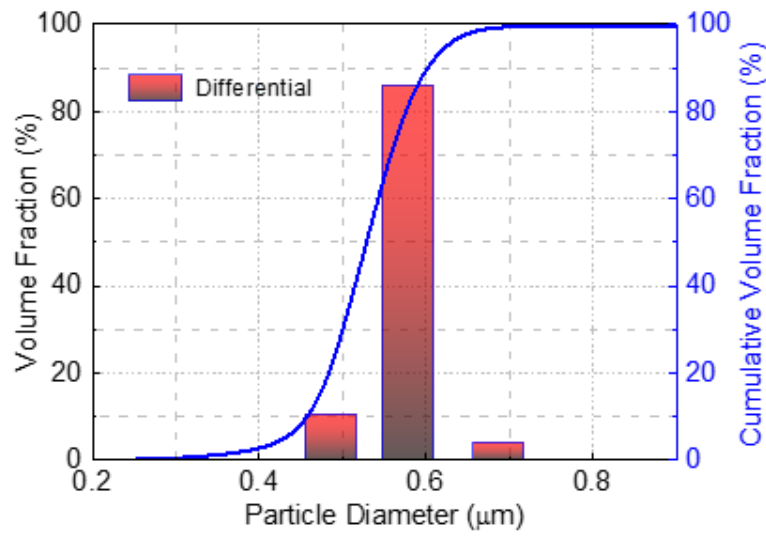
Figure 2. The particle size distribution of the highly purified Na-montmorillonite.